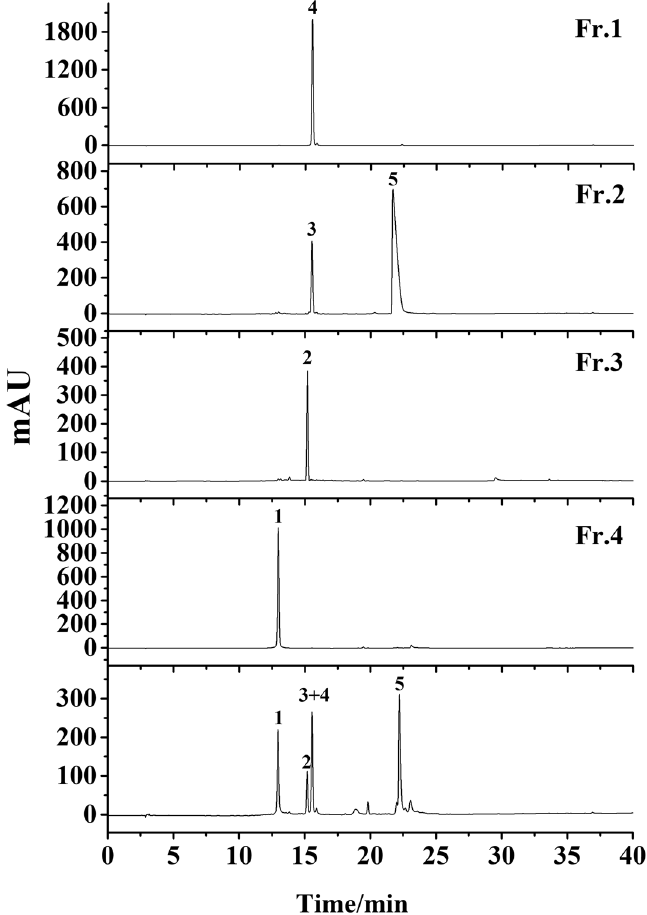
Figure 2. HPLC analysis of four fractions from HSCCC. Conditions: column, Platisil ODS-C18 analytical column (250 mm × 4.6 mm i.d., 5 μm); mobile phase, 0.1% acid water ( A ) and methanol ( B ), gradient elution